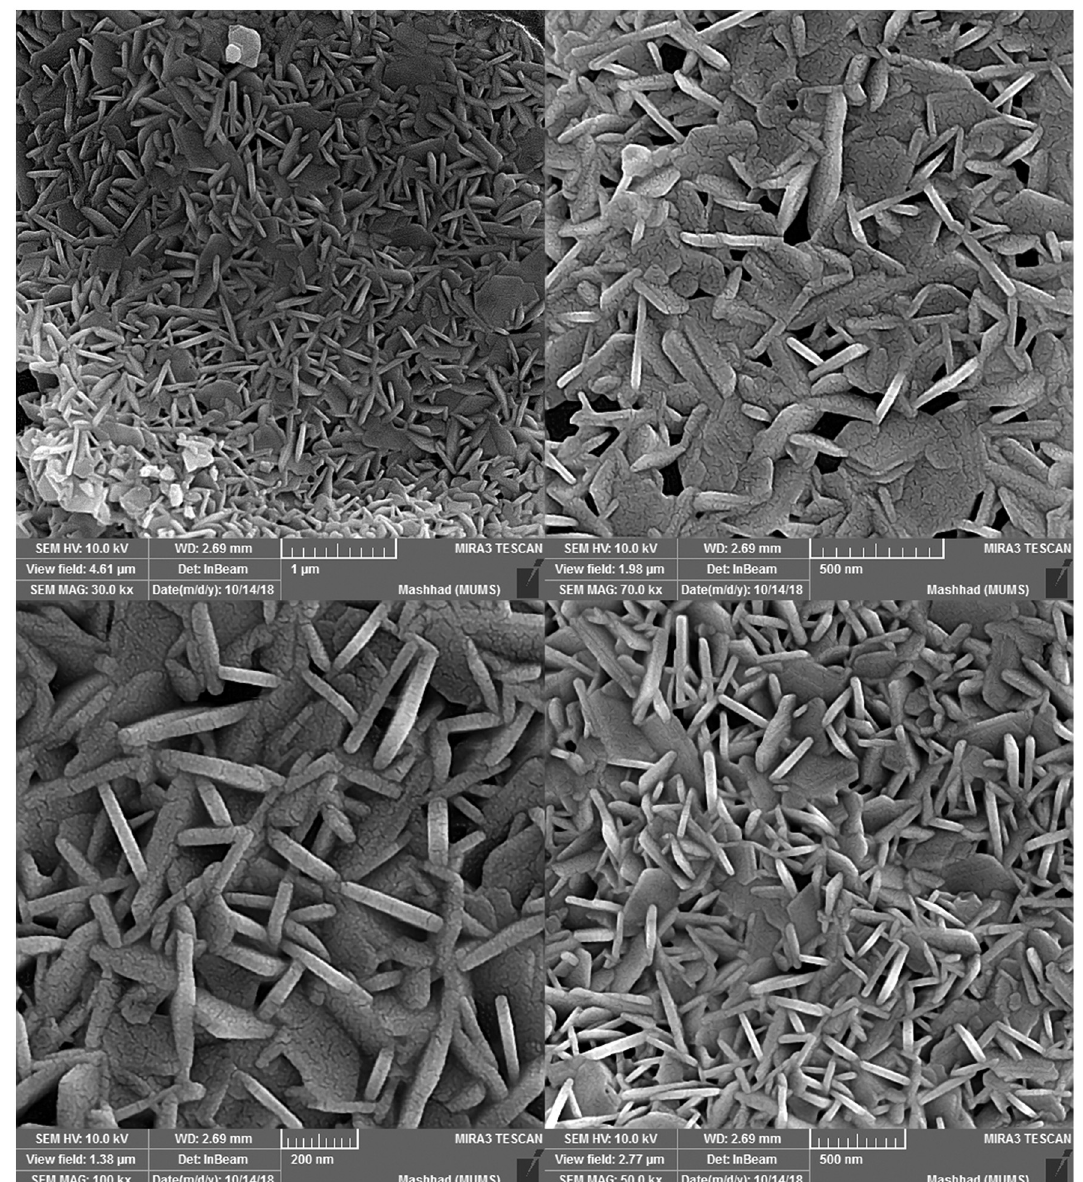
Figure 9: SEM images of SrFe